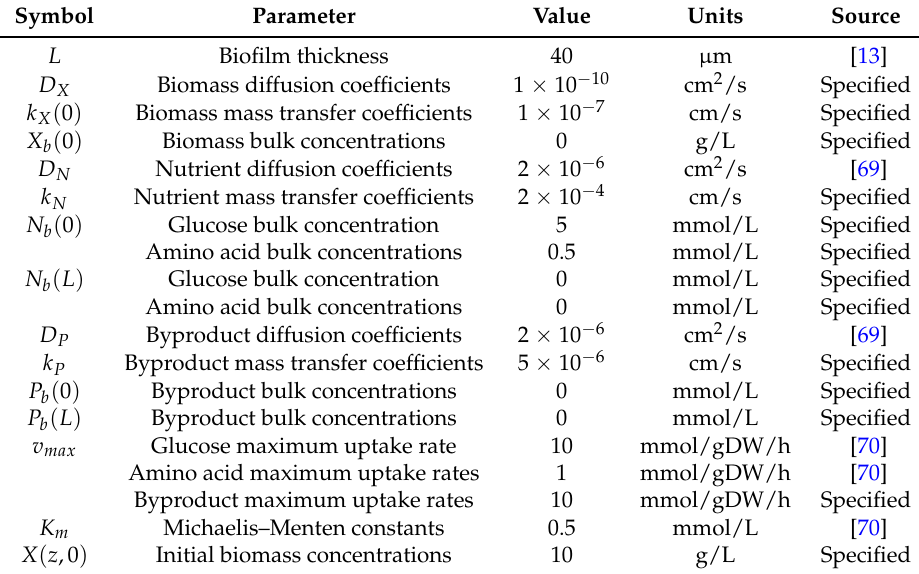
Table 1. Nominal parameter values for the multispecies biofilm model. For parameters that vary at the two biofilm boundaries, “0” denotes the biofilm–stool interface and ” L ” denotes the intestine–biofilm